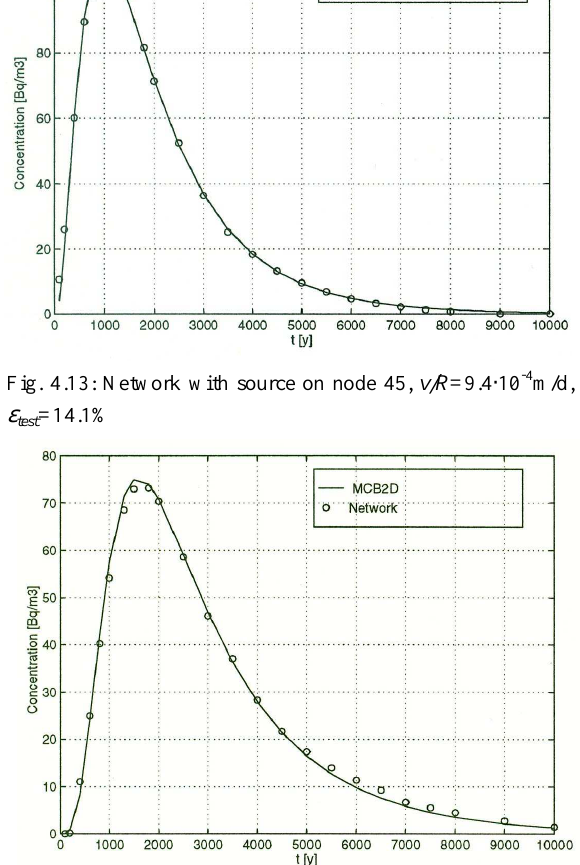
Fig. 4.14. Network with source on node 52, v/R= 8.5 (cid:215) 10 -4 m/d,